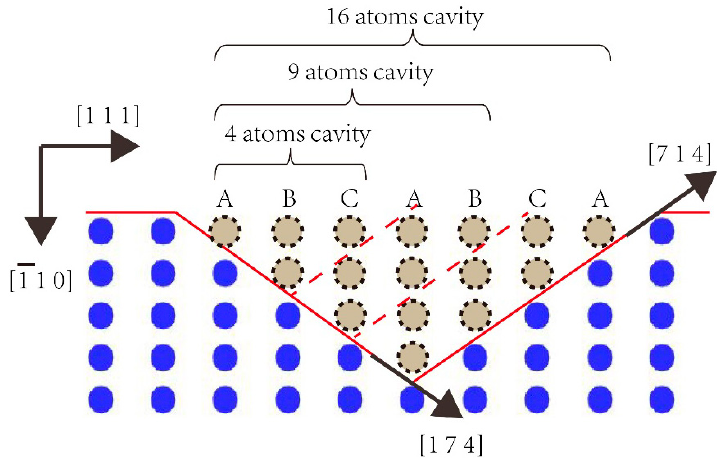
Figure 5. The boundary orientation sketch of the triangular defects.